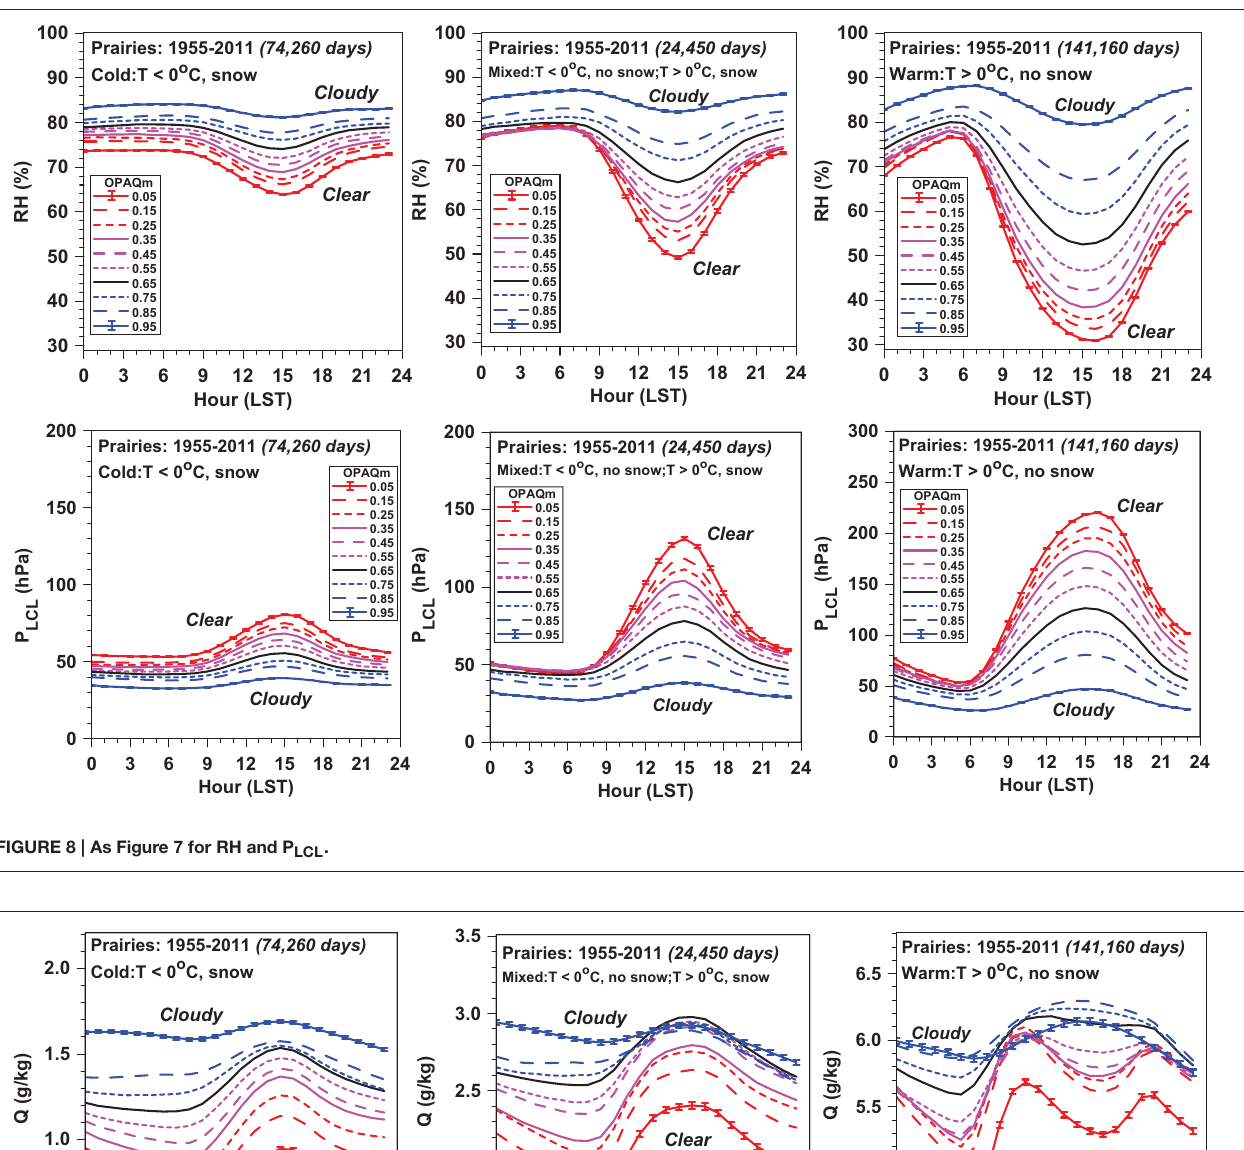
FIGURE 9 | As Figure 7 for mixing ratio, Q.